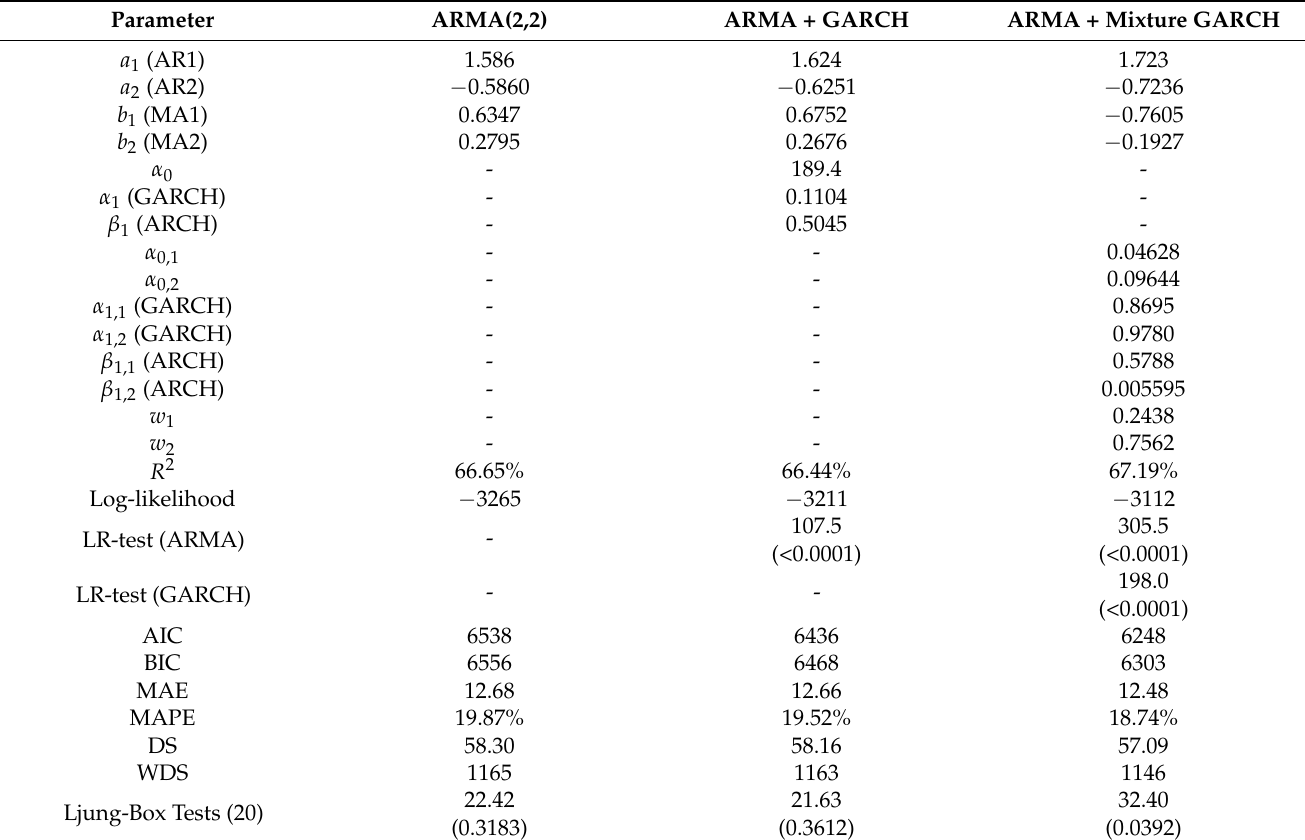
Table 9. Estimated parameters and performance measures for the third electricity price